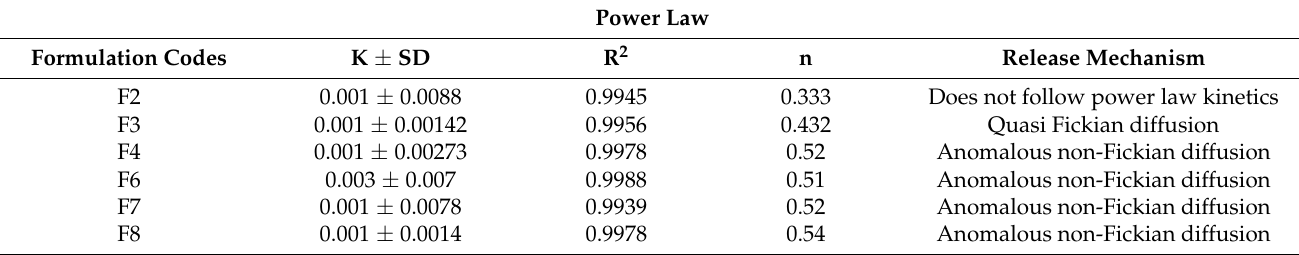
Table 8. Release kinetics of metronidazole floating effervescent tablets at 100 rpm. Power